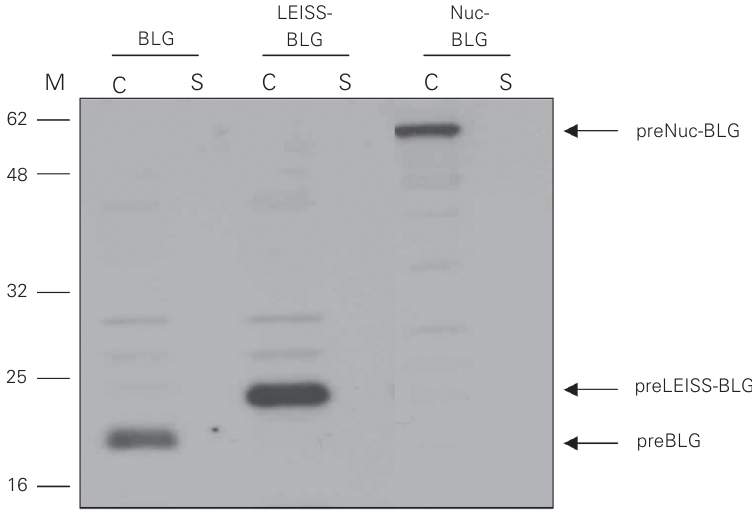
Figure 2. Production of BLG, LEISS:BLG and Nuc-BLG fusions in Lactococcus lactis was detected by Western blot with anti-BLG antibodies from induced cultures of the recombi- nant strains NZ9000 (pSEC:BLG), NZ9000 (pSEC:LEISS:BLG) and NZ9000 (pSEC:LEISS:Nuc- BLG). The migration positions of the precursor forms preBLG, preLEISS:BLG and preNuc- BLG are indicated by arrows. BLG = bovine ß-lactoglobulin; LEISS = synthetic propeptide; Nuc = staphylococcal nuclease; M = positions and sizes of molecular mass markers (kDa); C = cell lysates; S = supernatant